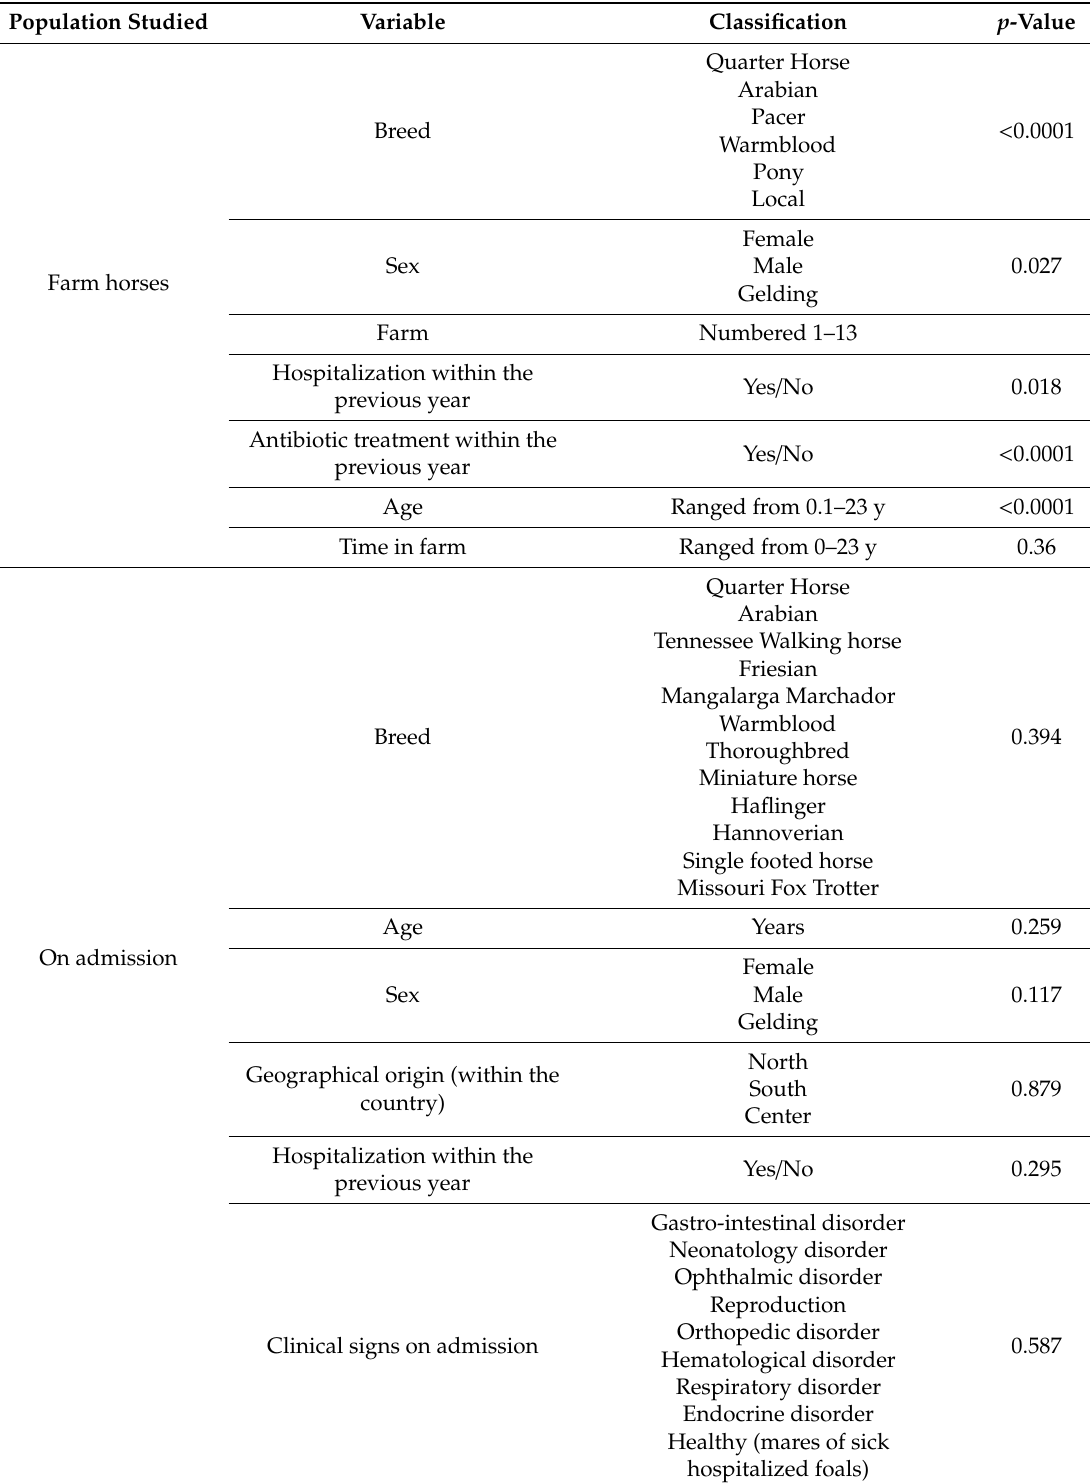
Table A2. Results of univariable analysis of variables gleaned from the medical records (horses on admission and during hospitalization) and owners’ questionnaires (farm horses). Variables were evaluated for association with the outcome of ESBL-E shedding status of the individual